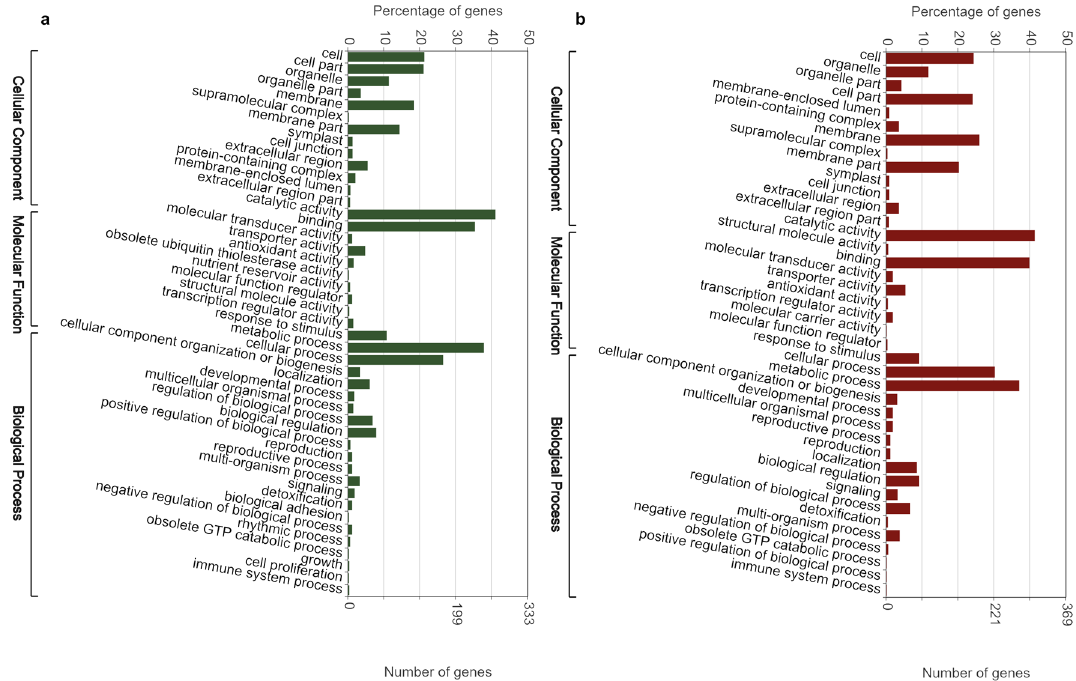
Figure 3. Gene ontology distribution of DEGs: ( a ) SosatC88vs Souna3 (non-treated); ( b ) SosatC88 vs Souna3 (MeJA-treated).